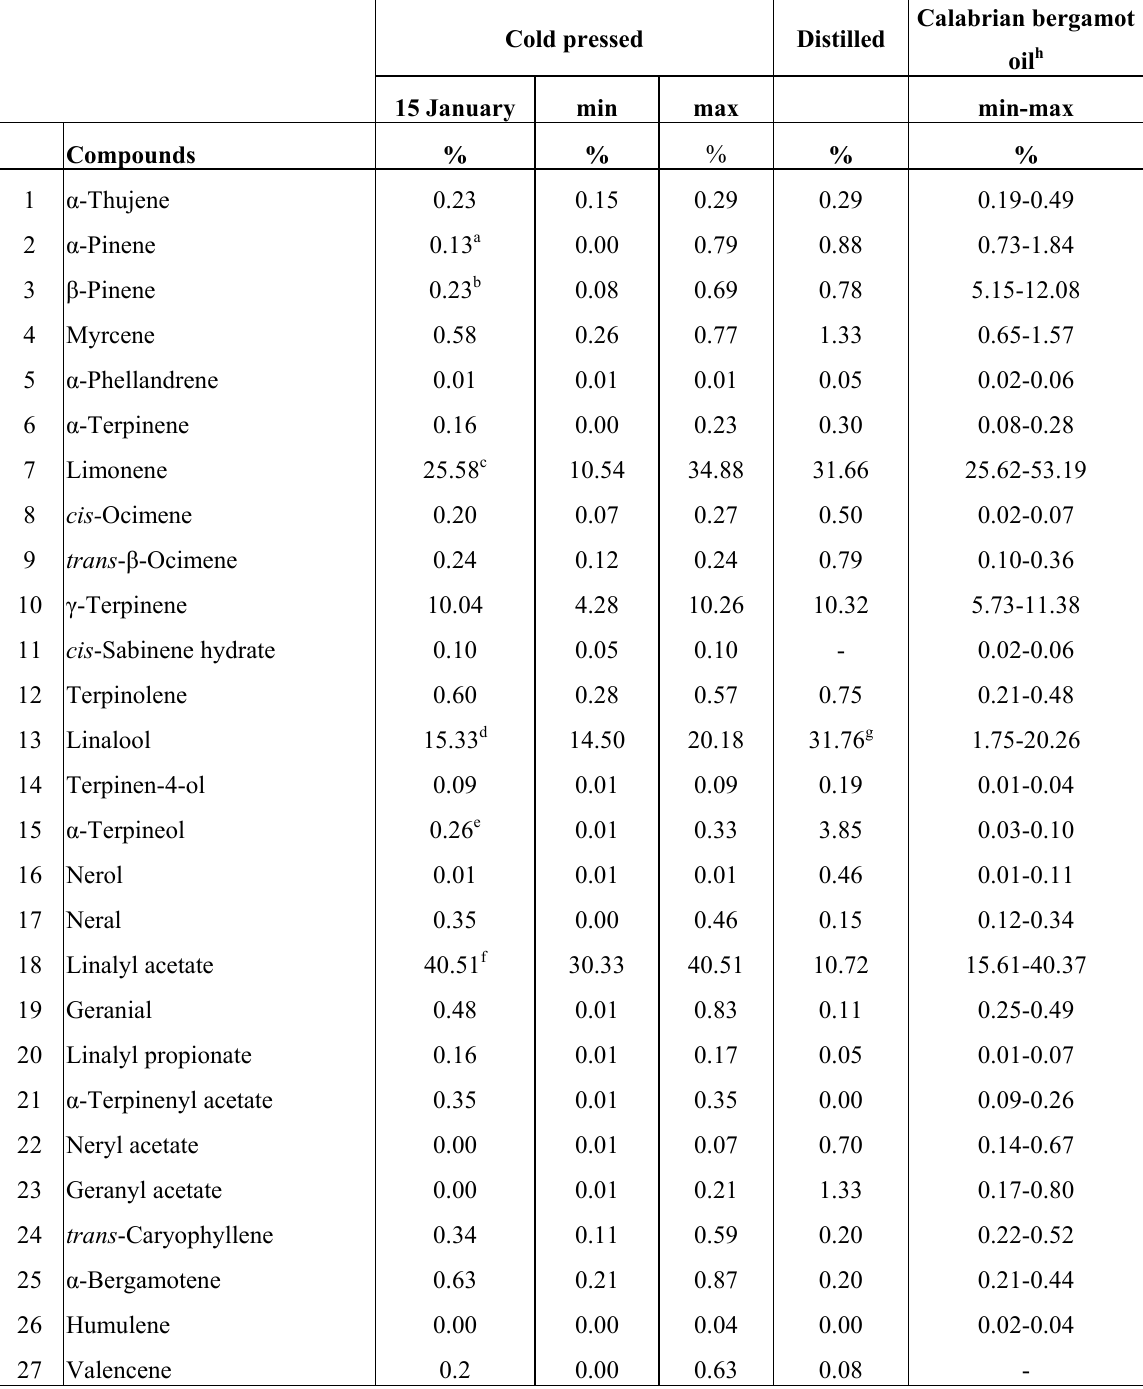
Table 1 . Composition of cold pressed oil of bergamot fruit harvested on 15 th of January showing the best quality values. The minimum and maximum percentage of each component has been recorded over a two year period. For comparison, the composition of the 15 January sample by atmospheric hydrodistillation is also presented as well as the min and max percentages of the main components of cold pressed Calabrian bergamot oil